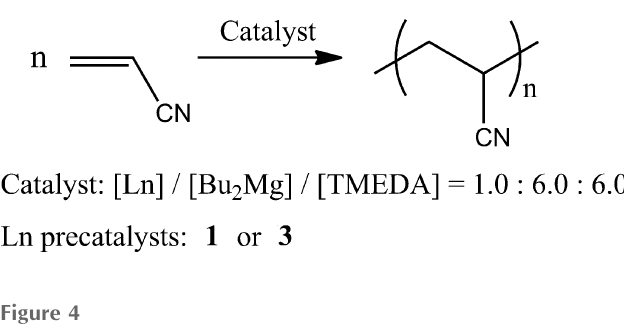
Figure 4 Acrylonitrile polymerization